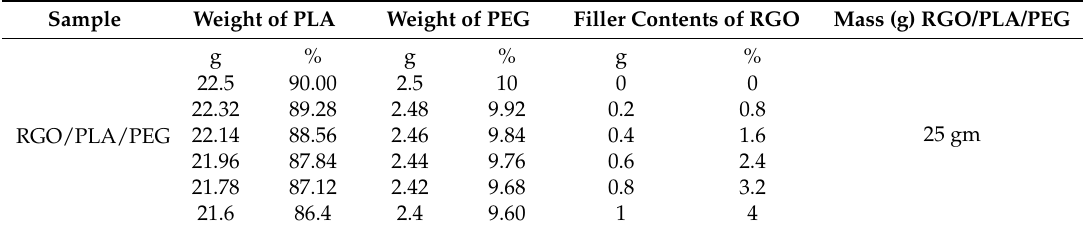
Table 1. Composition of RGO/PLA/PEG nanocomposites.